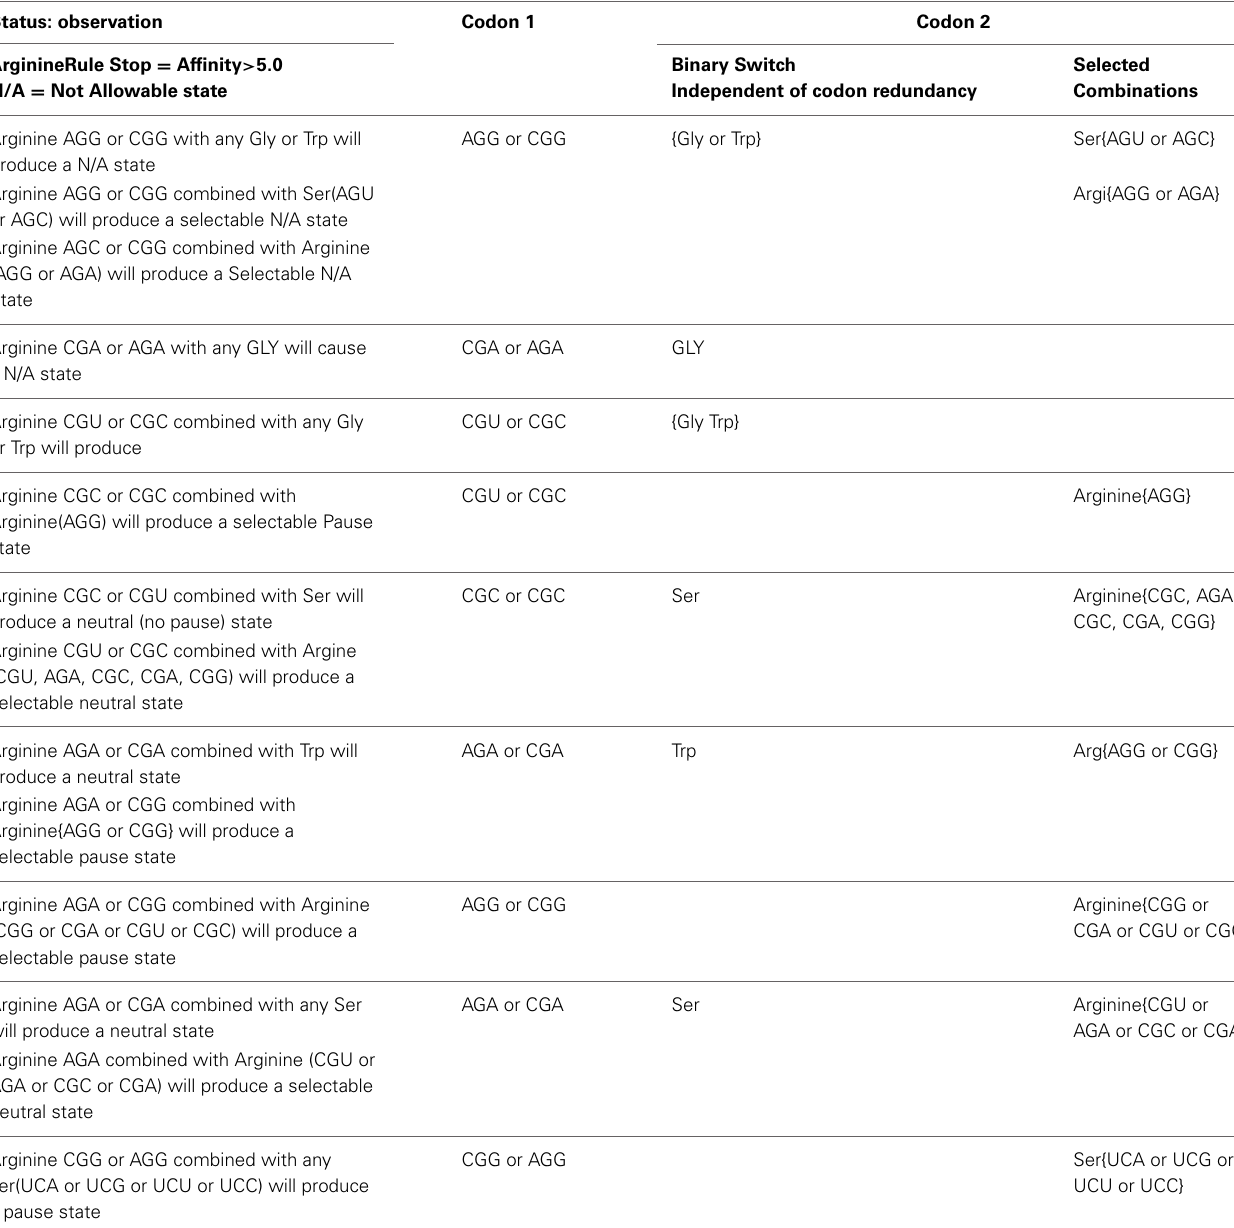
Table 3A | Tabulation of observations and rules that govern arginine to [trp, ser, arg, gly] combination with respect to pausing, neutral, and N/A states for the N/A metric >